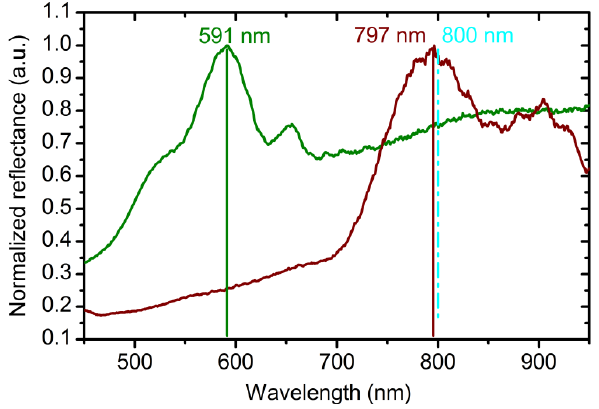
Figure 3. Reflectance spectra of anodic titanium oxide photonic crystals recorded at normal incidence of light. (Green line) PC_1 (PC — photonic crystal) was synthesized using Equations (2) and (4) for the optical path length (OPL) calculation. Parameters of the synthesis: t 0 = 50 min; L total = 20000 nm; L 0 = 400 nm. (Red line) PC_2 was prepared using Equations (5) and (6) for the OPL calculation. Parameters of the synthesis: t 0 = 50 min; L total = 16000 nm; L 0 = 400 nm. Vertical cyan dashed line and solid lines show the expected and experimental photonic band gap positions, respectively.